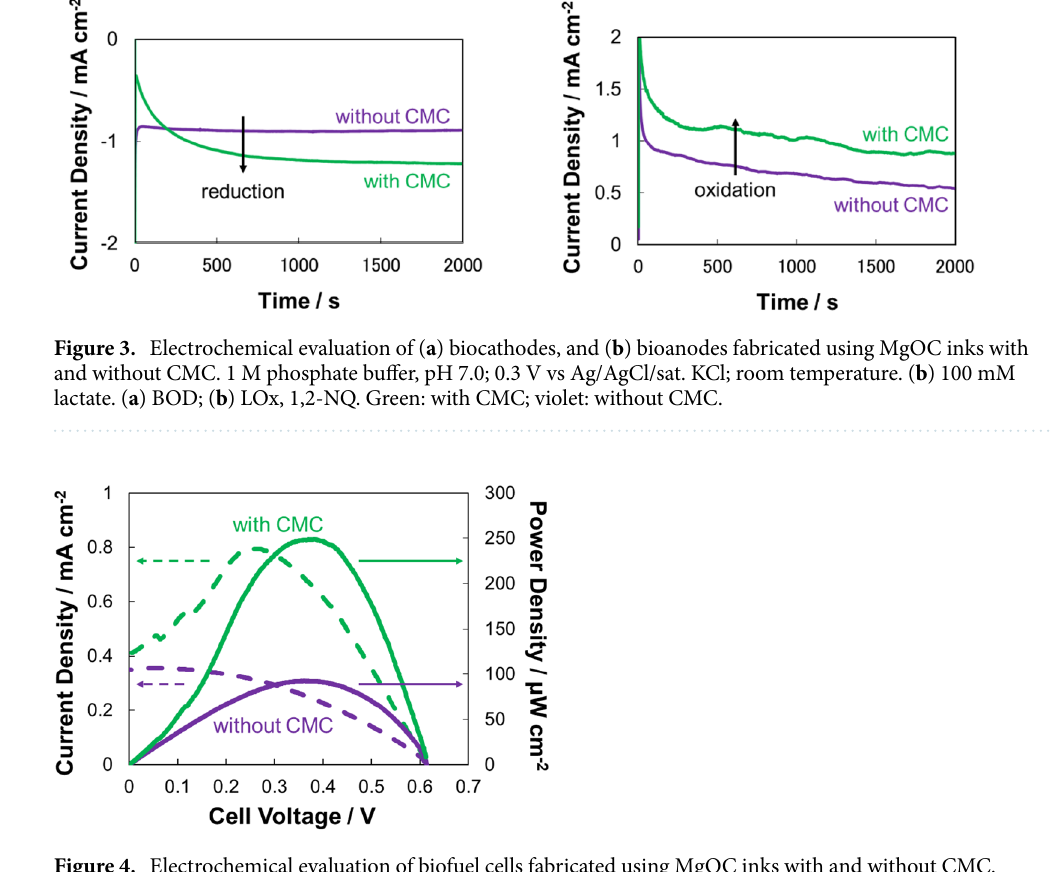
Figure 4. Electrochemical evaluation of biofuel cells fabricated using MgOC inks with and without CMC. 1 M phosphate buffer, pH 7.0; 100 mM lactate; humidity 70%; temperature 36 ºC. Biocathode enzyme: